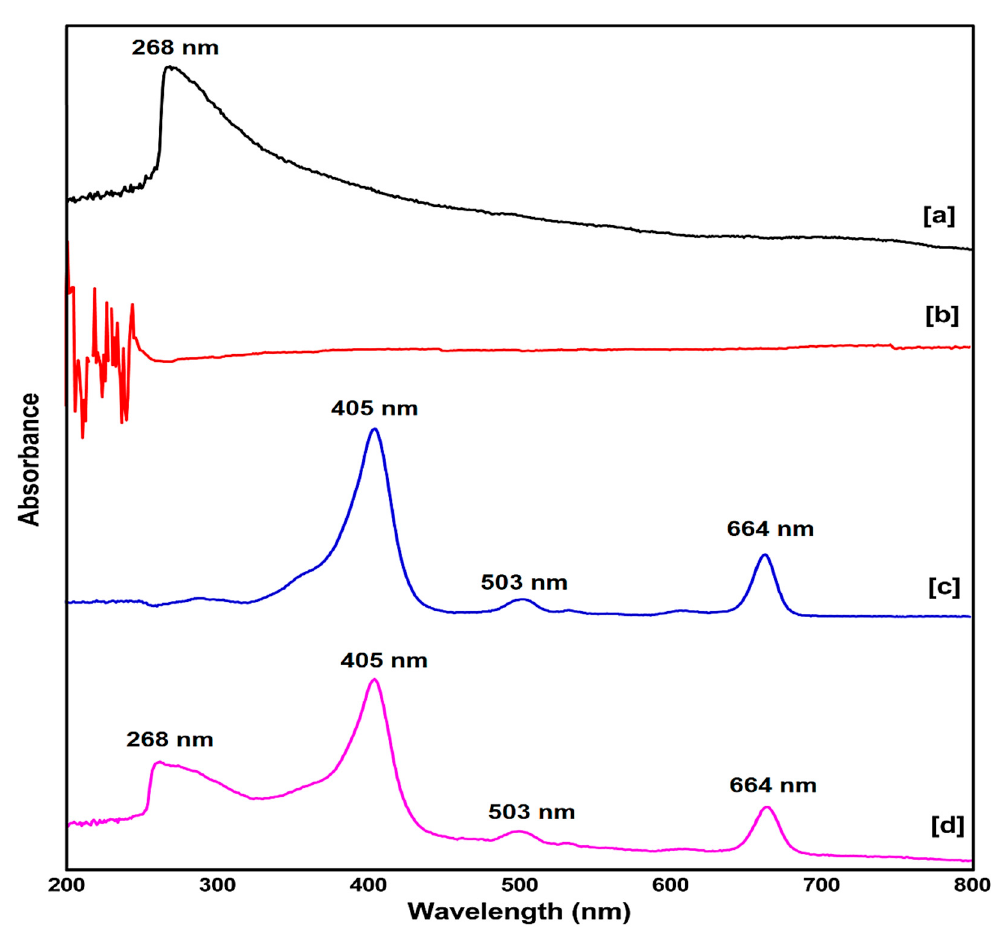
Figure 1. UV-vis spectroscopy of ( a ) SWCNTs ( b ) H.A ( c ) Ce6 ( d ) SWCNTs-HA-Ce6.